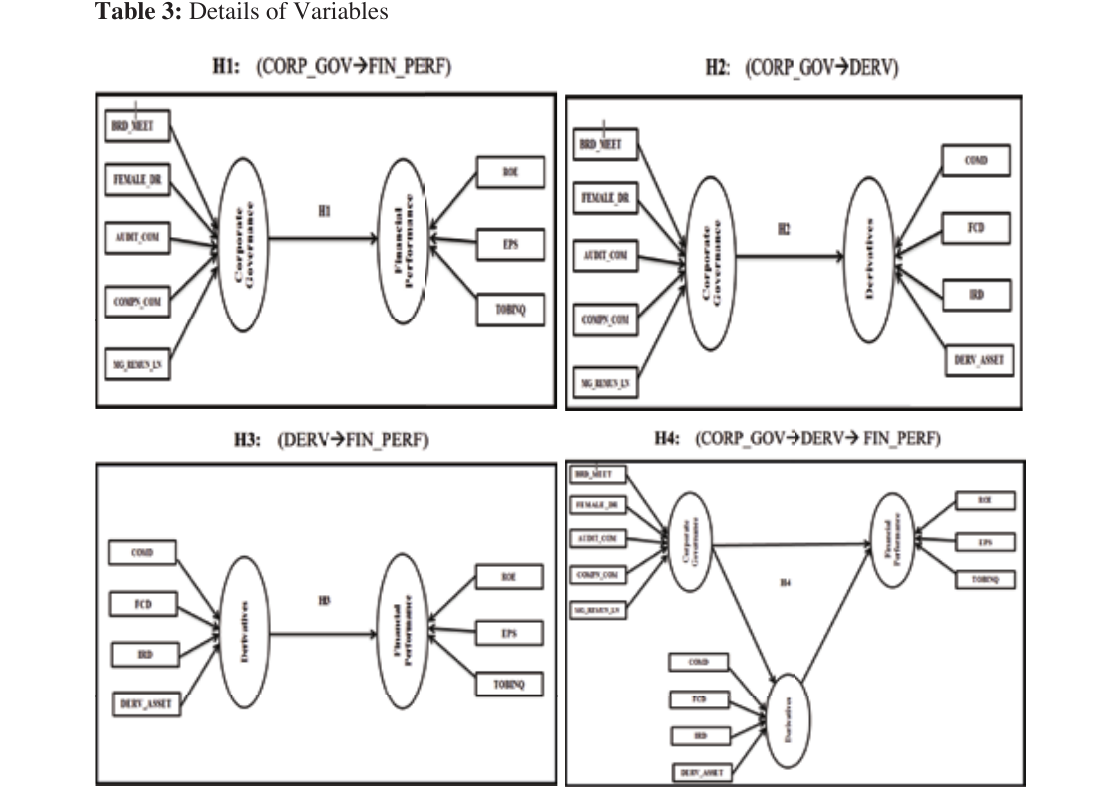
Table 3: Details of